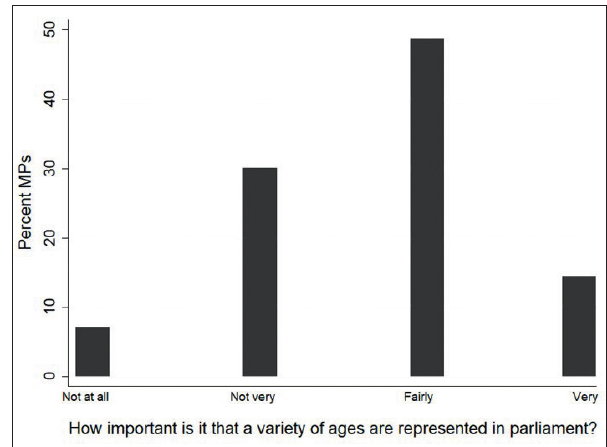
Figure 4: Parliamentarian responses to the PARTIREP survey